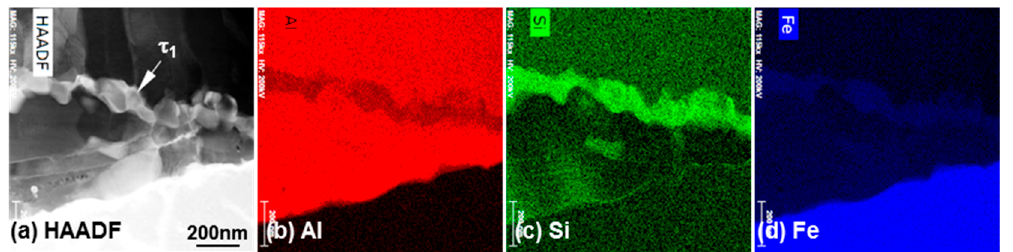
Figure 7. ( a ) transmission electron microscopy (TEM) images of the Area A in Figure 4a using focused ion beam (FIB) technique, ( b ) enlarged image of Area X, ( c ) enlarged area of Area X1, ( d ) enlarged area of Area X2, and ( e ) enlarged area of Area Y, respectively.